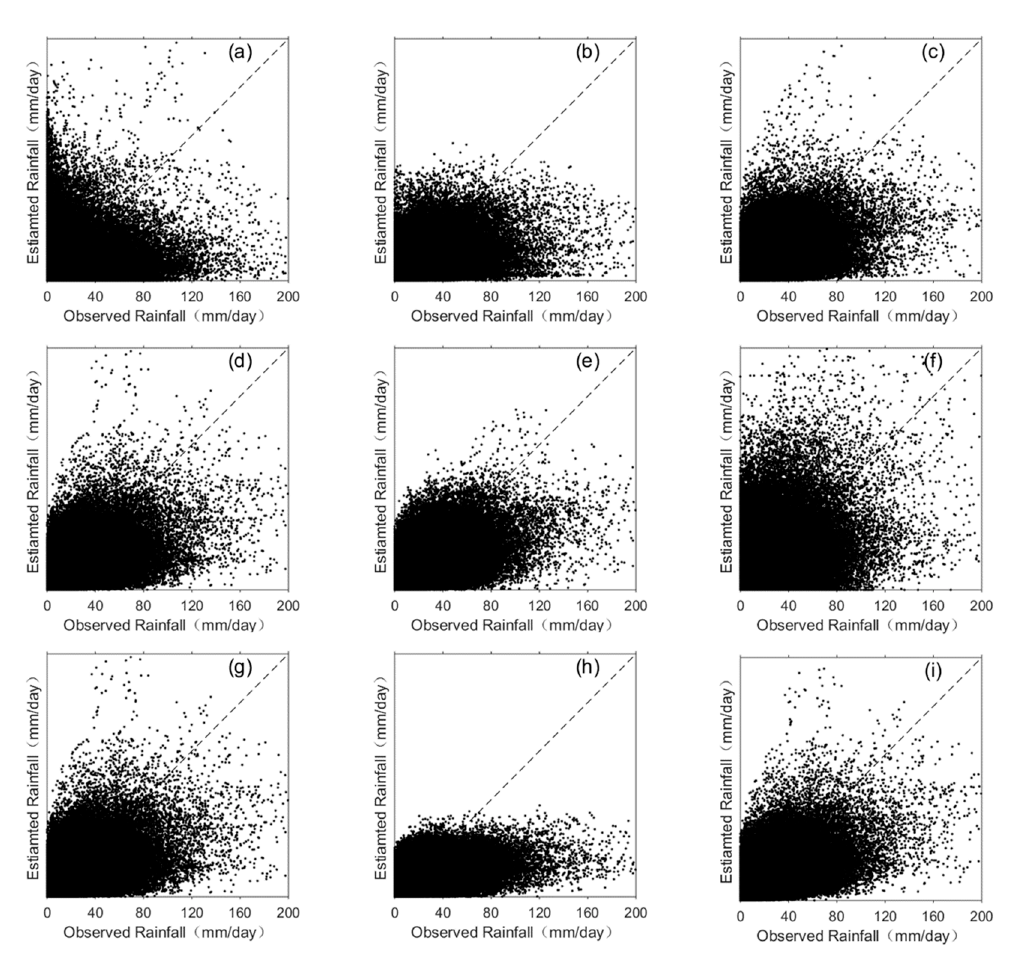
Figure 4. Scatterplots of estimated precipitation using di ff erent predictors against observed precipitation (daily scales): ( a ) Original ERA-Interim precipitation, ( b ) Sea level mean pressure, ( c ) Geopotential Height, ( d ) Geopotential Height filed and total column water, and ( e ) all circulation variables described in Section 2.2. And scatterplots of estimated precipitation using di ff erent downscaling methods against observed precipitation (daily scales): ( f ) Quantile mapping, ( g ) CNN networks, ( h ) SVM, and ( i ) ConvLSTM networks.